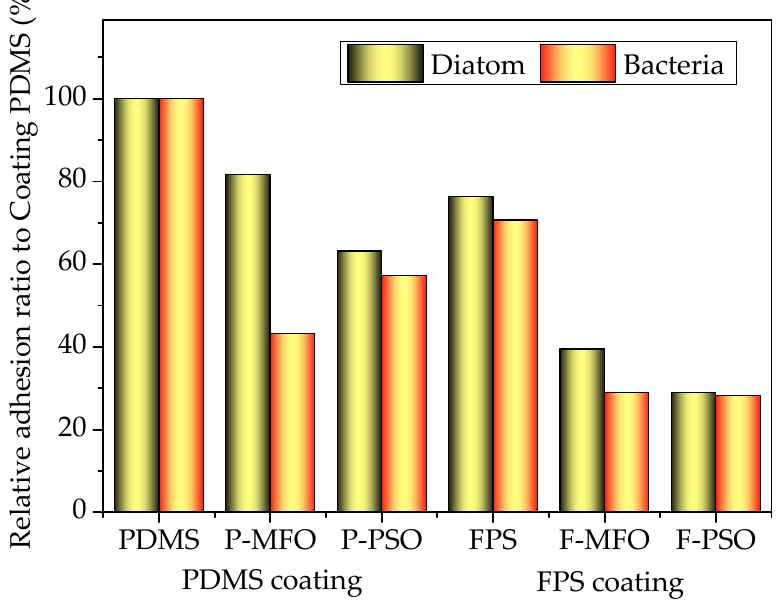
Figure 16. Relative ratio of attached organism on studied coating to PDMS